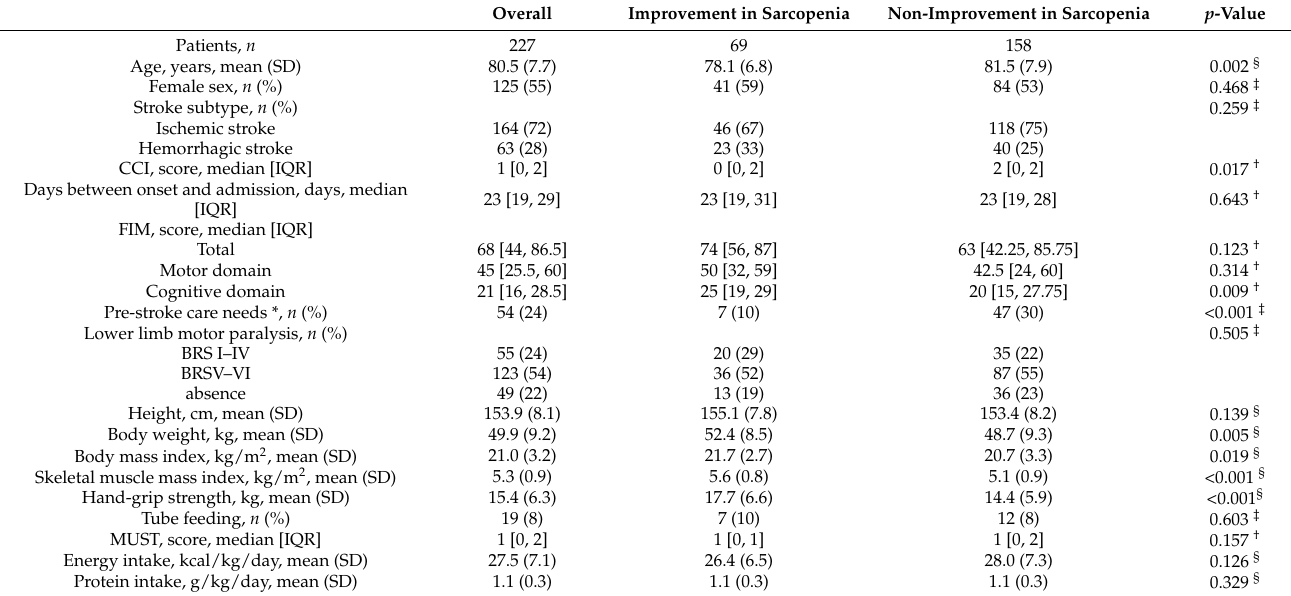
Table 1. Demographic characteristics of 227 post-stroke older patients with sarcopenia admitted to convalescent rehabilita- tion wards.